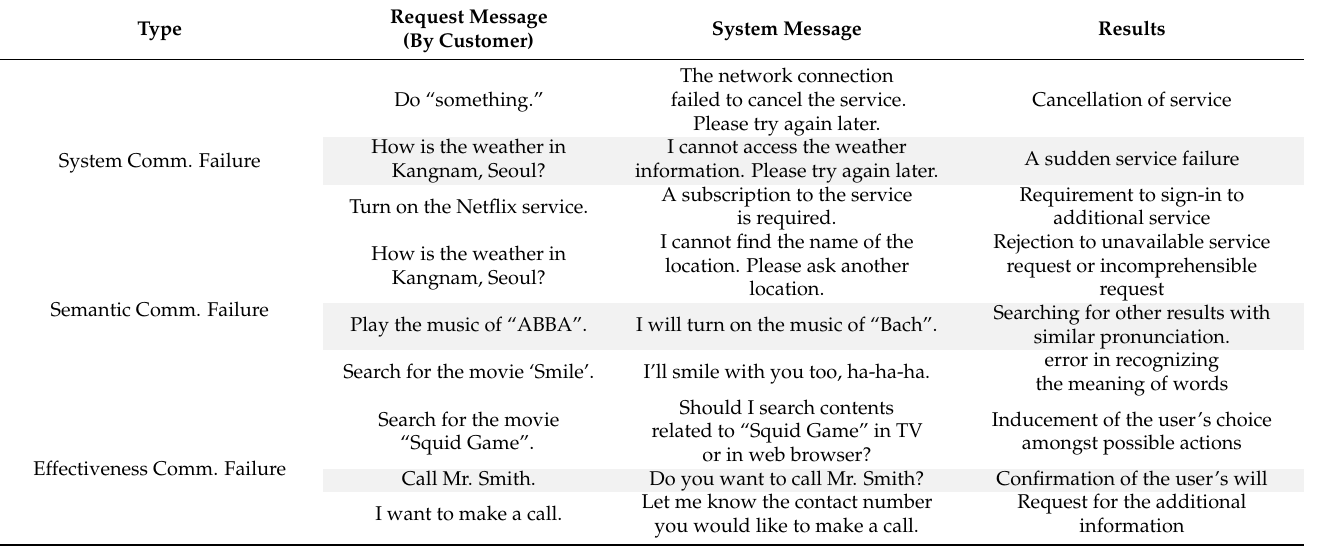
Table 2. Classification of the typical failure experiences of AI speaker